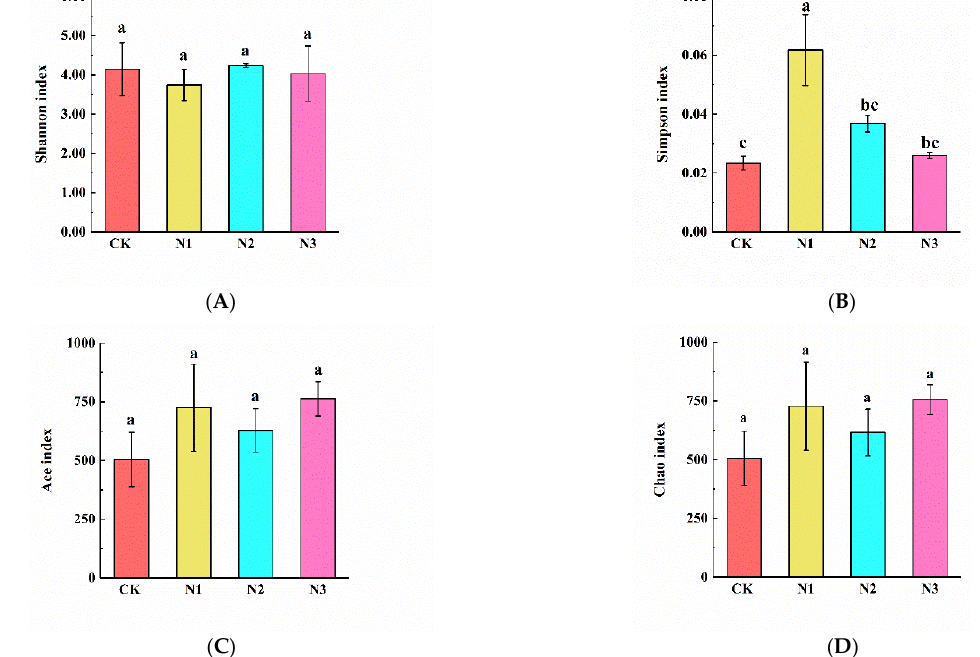
Figure 6. The alpha diversity of soil fungi under nitrogen addition treatment. CK: 0 g N·m − 2 ·year − 1 ; N1: 6 g N·m − 2 ·year − 1 ; N2: 12 g N·m − 2 ·year − 1 ; N3: 24 g N·m − 2 ·year − 1 . ( A ): Shannon index; ( B ): Simpson index; ( C ): Ace index; ( D ): Chao index. Different letters indicate a significant difference among different concentrations of nitrogen addition treatments ( p < 0.05) as estimated by one-way ANOVA and a post hoc Duncan’s multiple-range test.